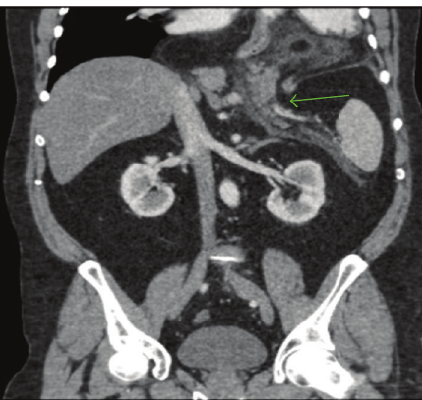
Figure 1: Coronal plane; hiatal hernia; herniation of the stomach, the body and tail of the pancreas, and the first part of the duodenum.